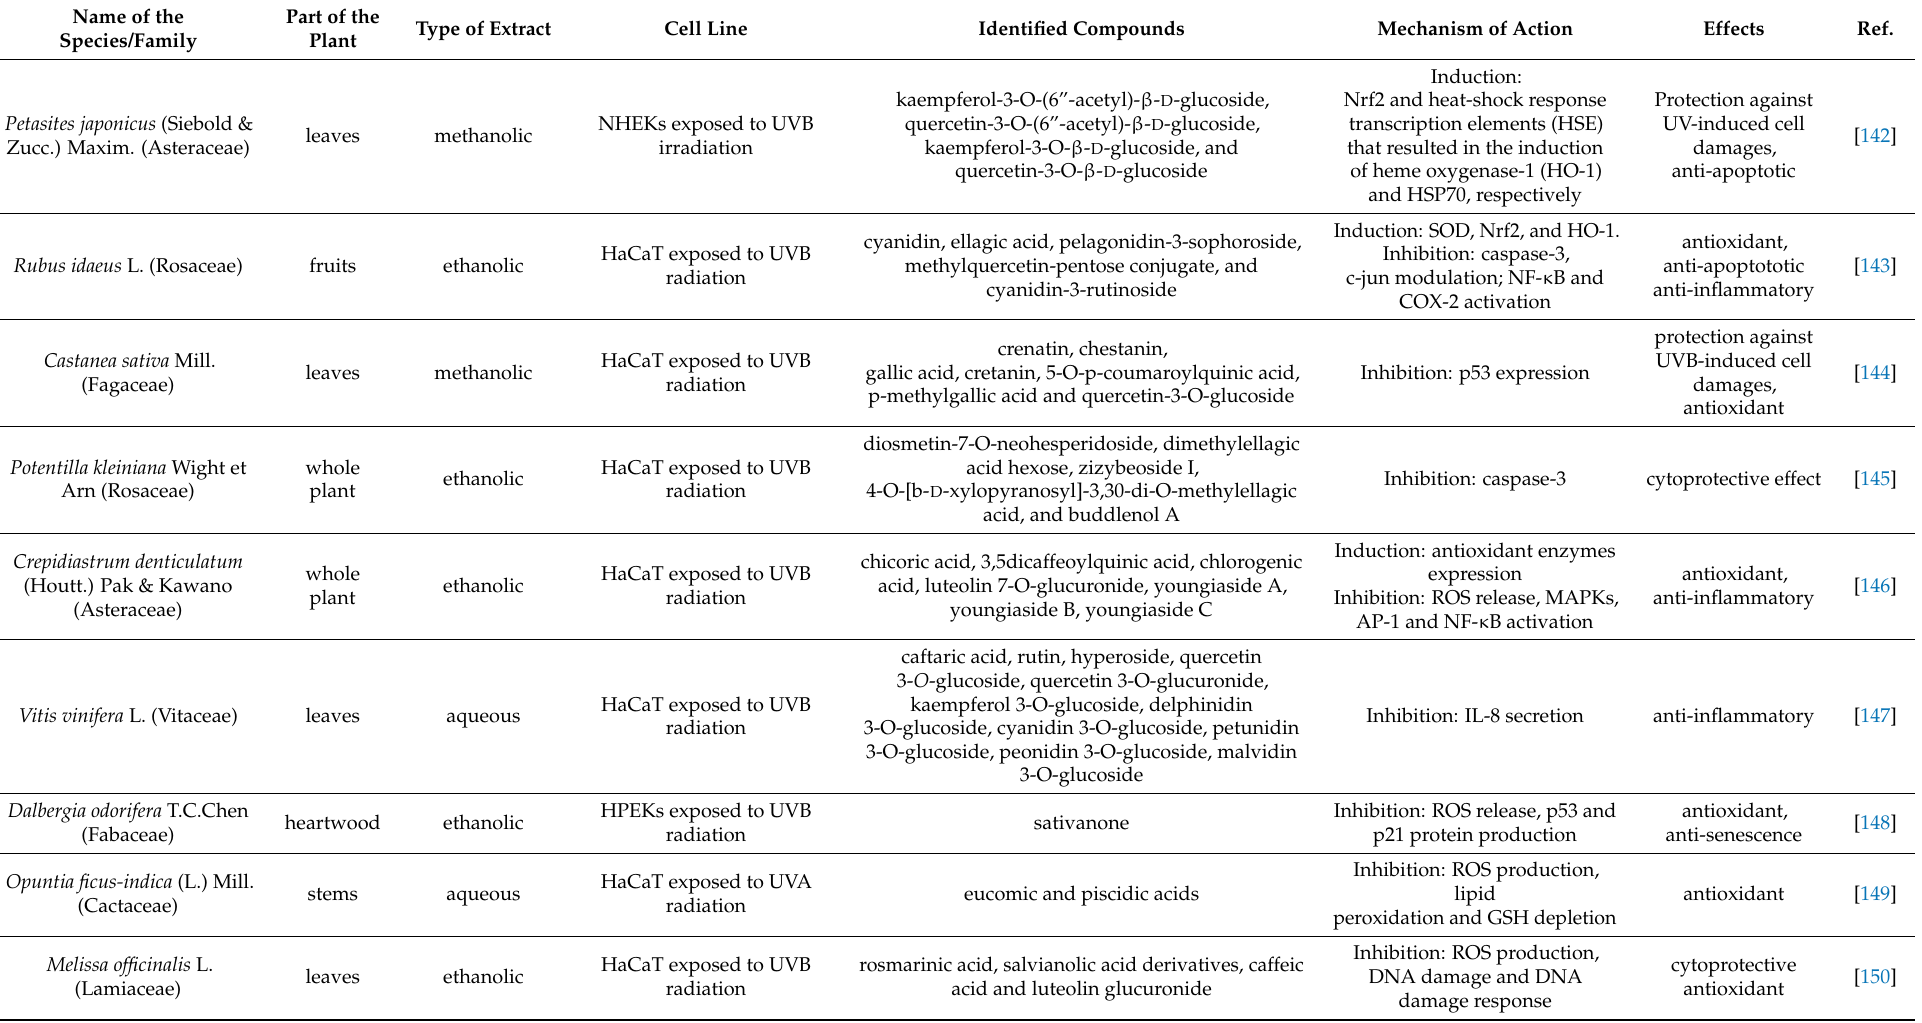
Table 3. Selected plant extracts from different species with identified compounds and their in vitro effect on UV-radiation-stimulated human